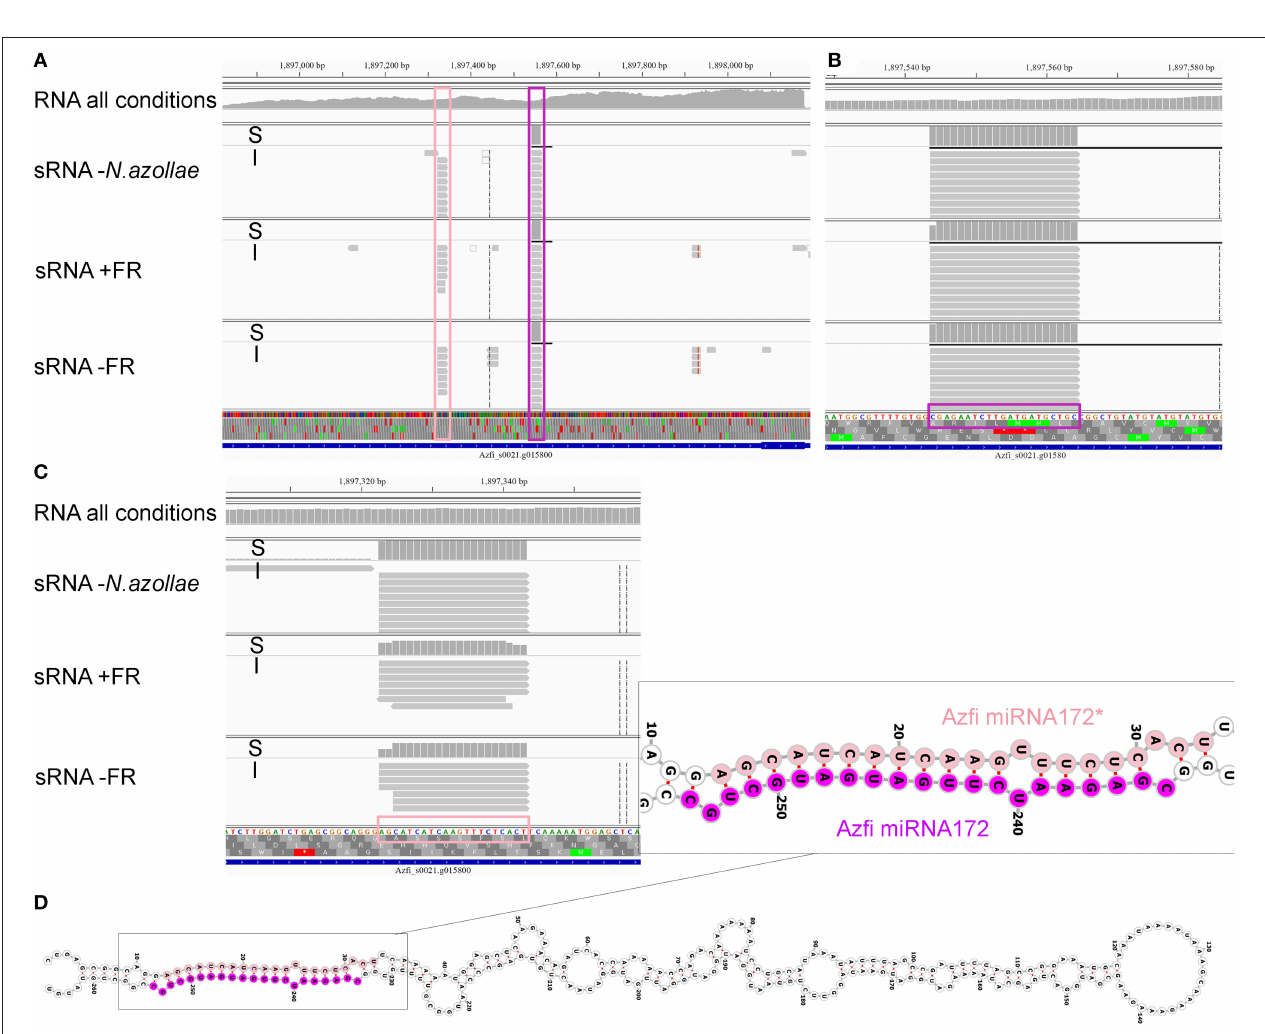
FIGURE 5 | genome. sRNA read counts were further averaged over all samples considered, then the averages with the same size summed up, which yielded the sum of normalized read count averages and reflects how many sRNA are found for each size (read counts). For each sRNA size, we also calculated the mean number of